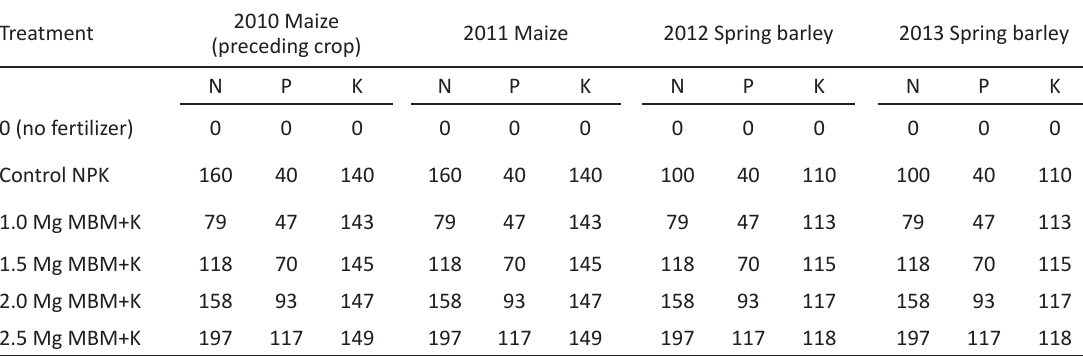
fertilizer rates in a four-year crop rotation